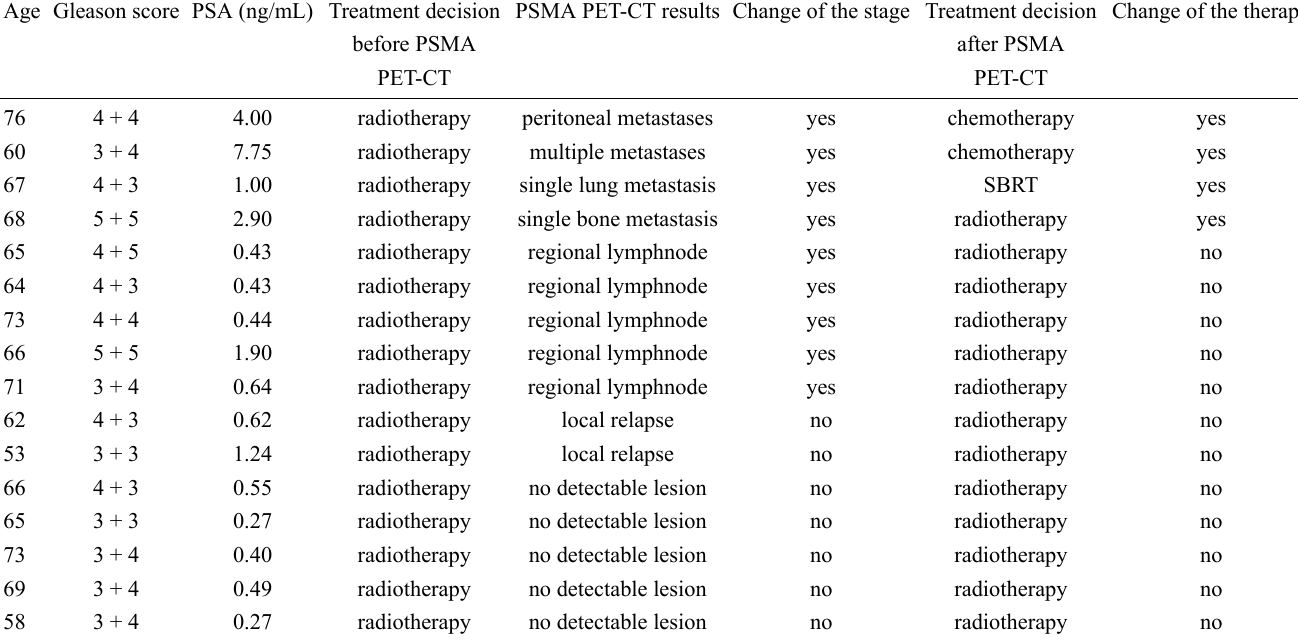
Table 1. Patients at biochemical recurrence following radical